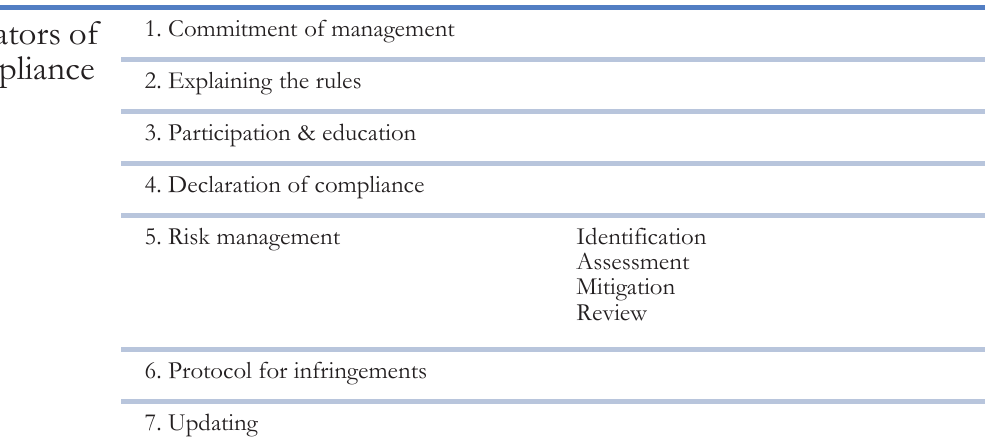
Figure 1 Seven indicators of a successful compliance